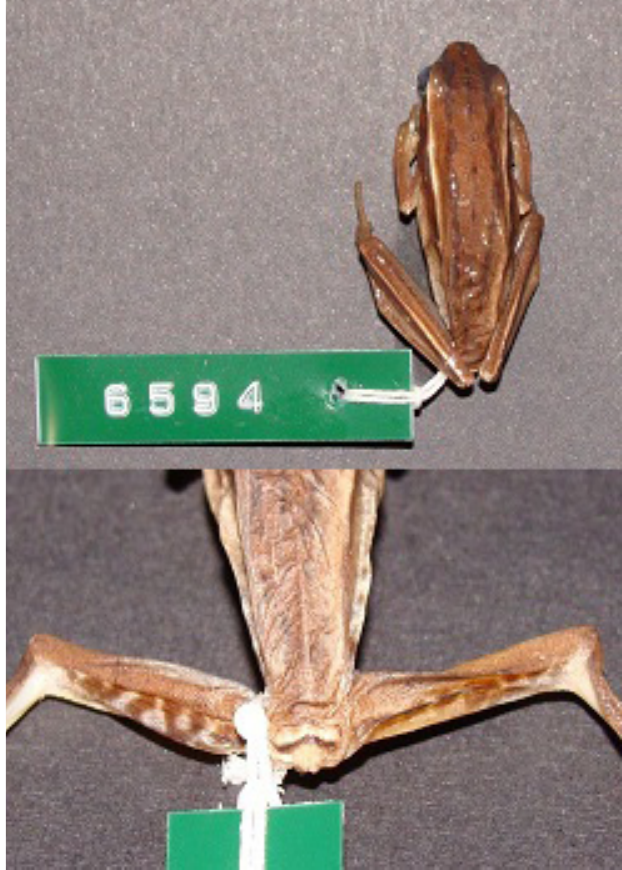
Figure 1. Hypsiboas caingua collected in the municipality of Tacuru, state of Mato Grosso do Sul, Brazil (MHNCI 6594). Upper, dorsal view; below, detail of the concealed surfaces of